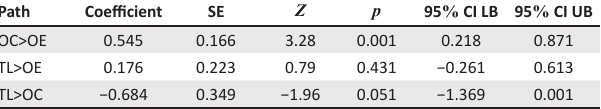
TABLE 6: Total effects between different paths.